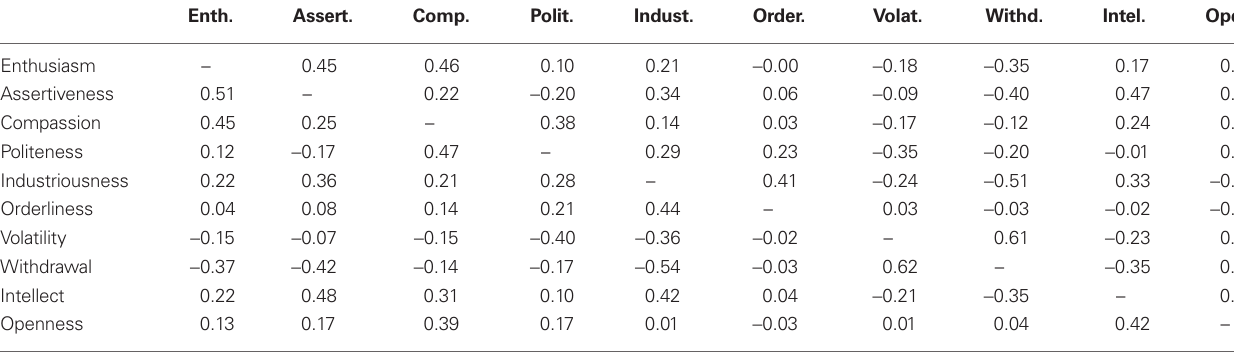
Table 3 | Correlations among aspects (raw